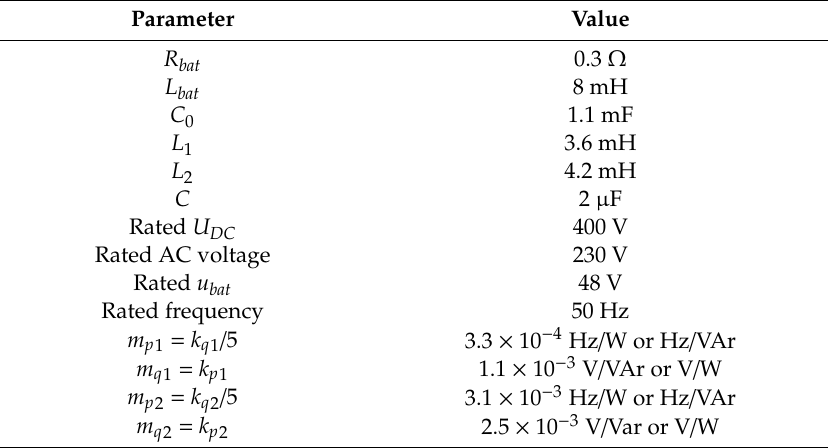
Table 2. Simulation parameters.